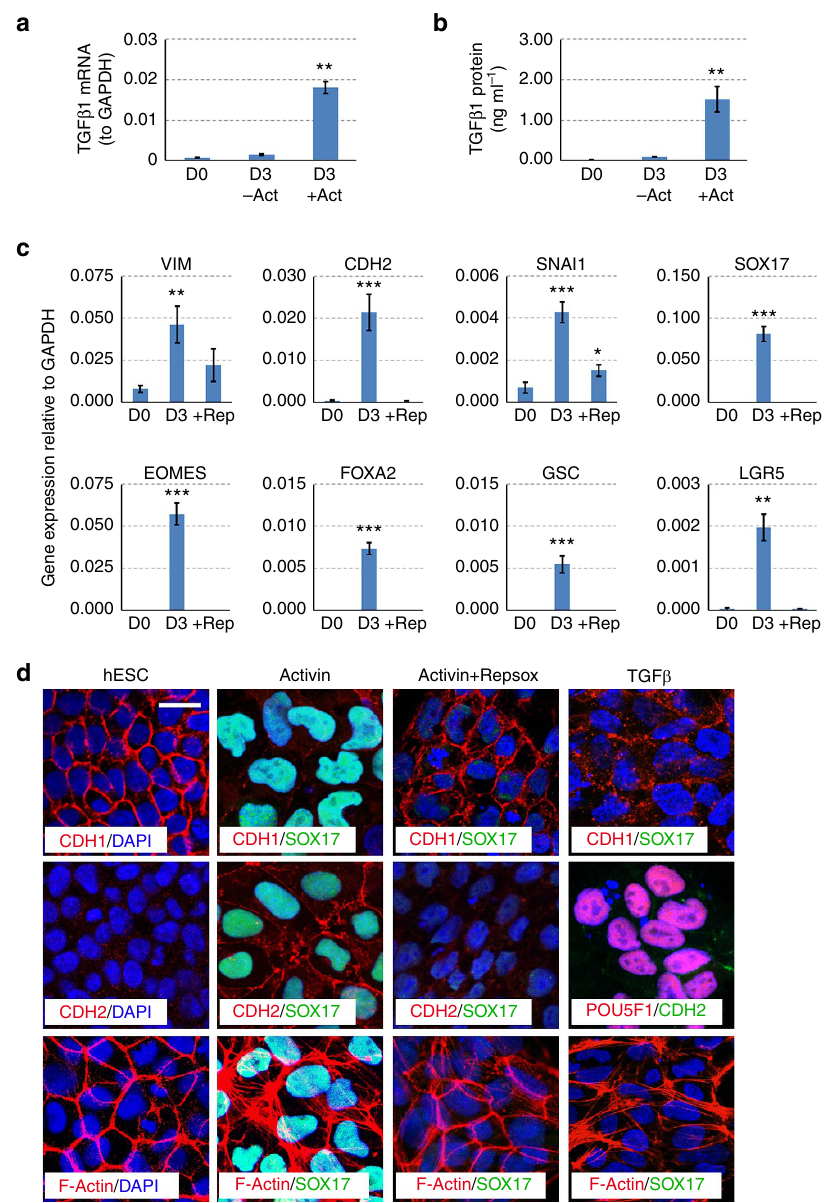
Figure 4 | TGF b mediates Activin A-induced EMT and DE formation. ( a ) qRT-PCR analysis of TGF b 1 expression levels in un-induced hESCs, or in differentiation media with or without Activin A (Act). The expression level of GAPDH is arbitrary set as 1. Data represent mean ± s.d. from three independent biological repeats (** P o 0.01 when compared to D0 using Student’s unpaired t -test). ( b ) Secreted protein levels of TGF b in conditioned medium at day 3 detected by ELISA. Data represent mean ± s.d. from three independent repeats (** P o 0.01 when compared to D0 using Student’s unpaired t -test). ( c ) qRT-PCR analysis for the indicated genes in the absence or presence of Repsox (Rep). Data represent mean ± s.d. from three independent repeats (* P o 0.05; ** P o 0.01; *** P o 0.001 when compared to D0 using Student’s unpaired t -test). ( d ) Immunofluorescence staining of Activin A-induced cells with or without Repsox. The right panels are cells treated with TGF b instead of Activin A. Scale bar, 20 m